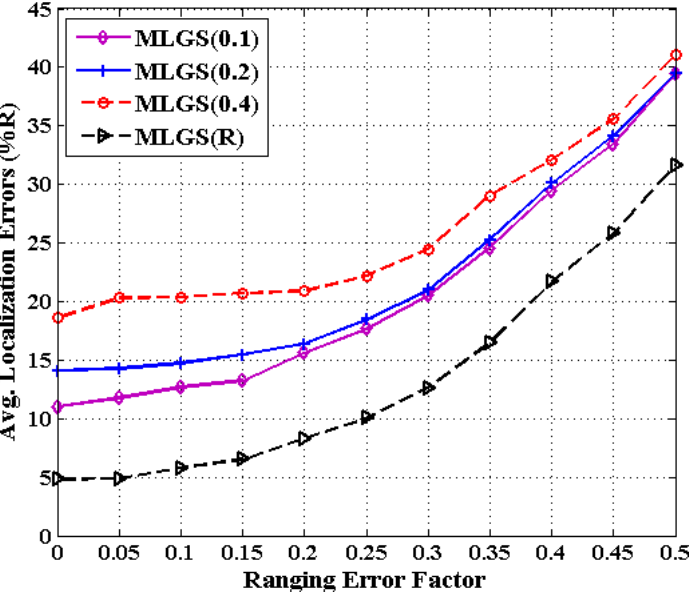
Figure 19. Average localization error versus grid granularity (anisotropic